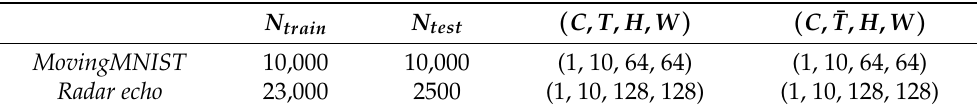
Table 4. Dataset